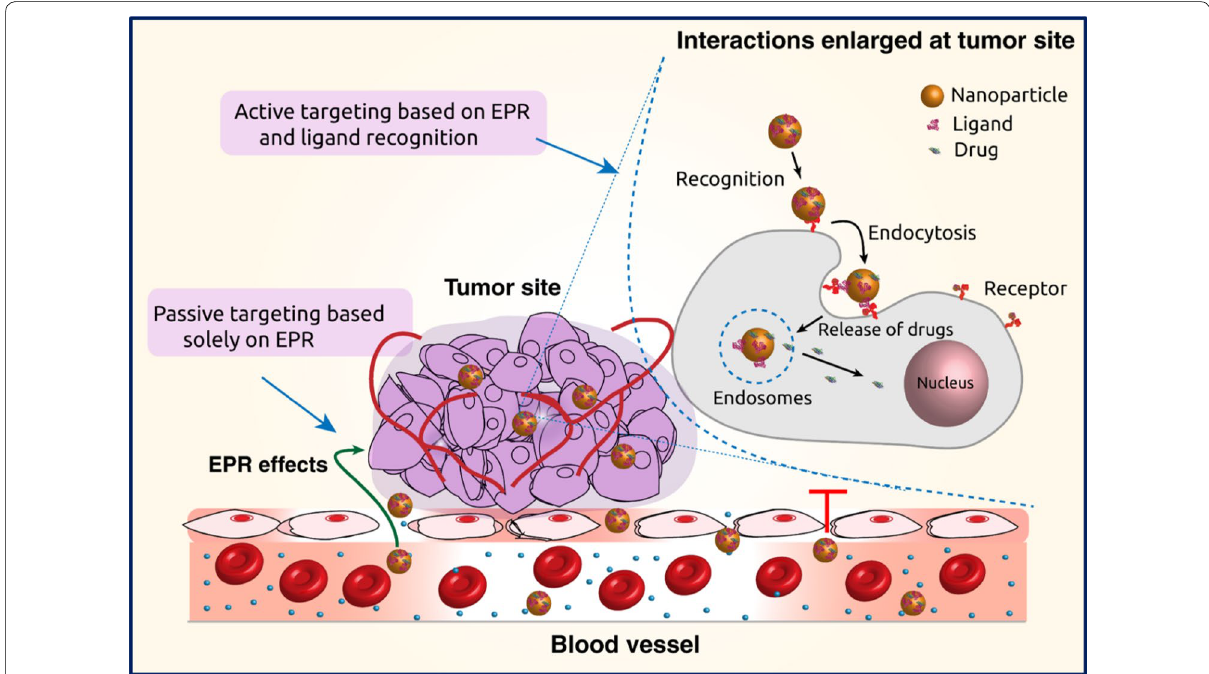
Fig. 2 Graphical illustration of passive and active drug targeting strategies. In passive targeting, the nanocarriers pass through the leaky walls and accumulate at the tumor site by the enhanced permeability and retention (EPR) effect. Active targeting can be achieved using specific ligands that bind to the receptors on the tumor